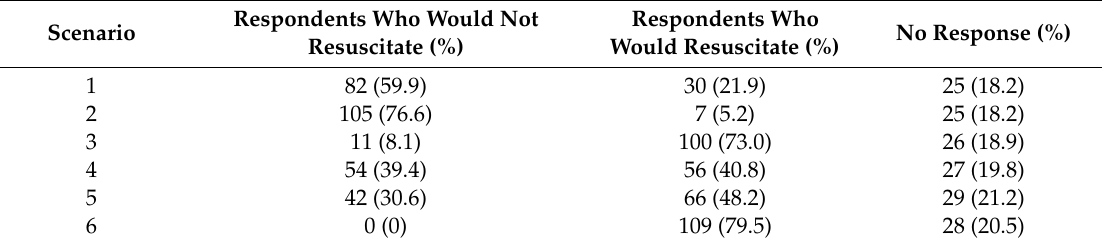
Table 2. Respondents who would and would not resuscitate by